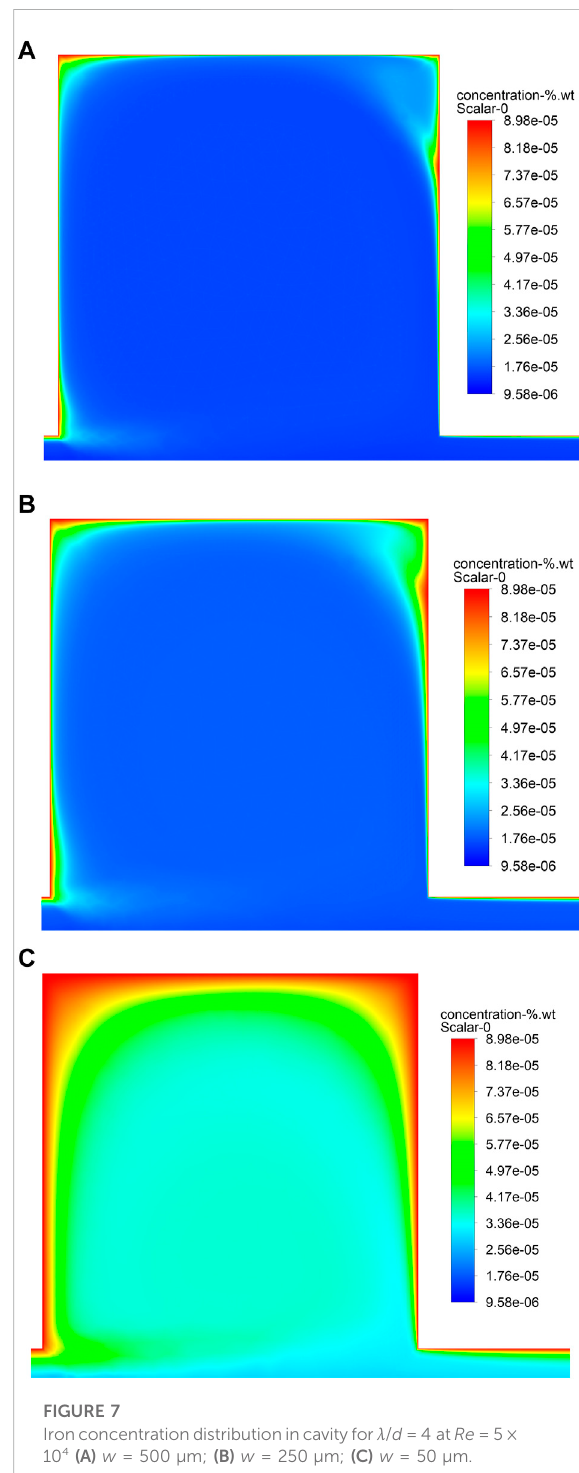
FIGURE 7 Ironconcentrationdistributionincavityfor λ / d =4 at Re =5× 10 4 (A) w = 500 μ m; (B) w = 250 μ m; (C) w = 50 μ